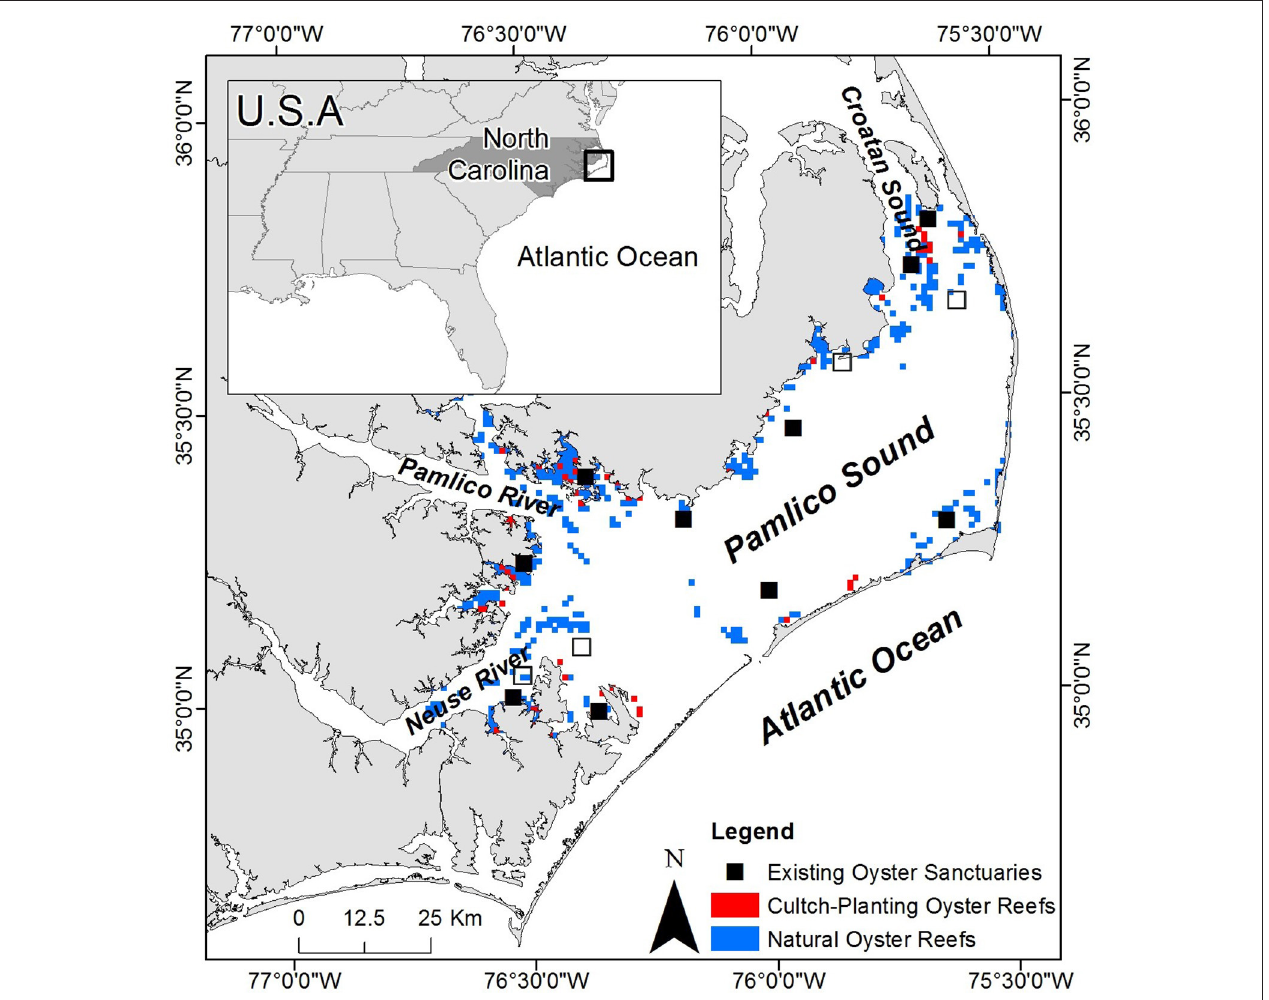
FIGURE 2 | Map of study system including Pamlico Sound, Croatan Sound, and Neuse and Pamlico Rivers. The locations of existing oyster sanctuaries are depicted by black squares including the 10 sanctuaries used for model validation (closed squares), as well as recently constructed sanctuaries (open squares). The locations of cultch-planting oyster reefs and natural oyster reefs are depicted by red and blue squares, respectively. Sanctuaries and reefs not to